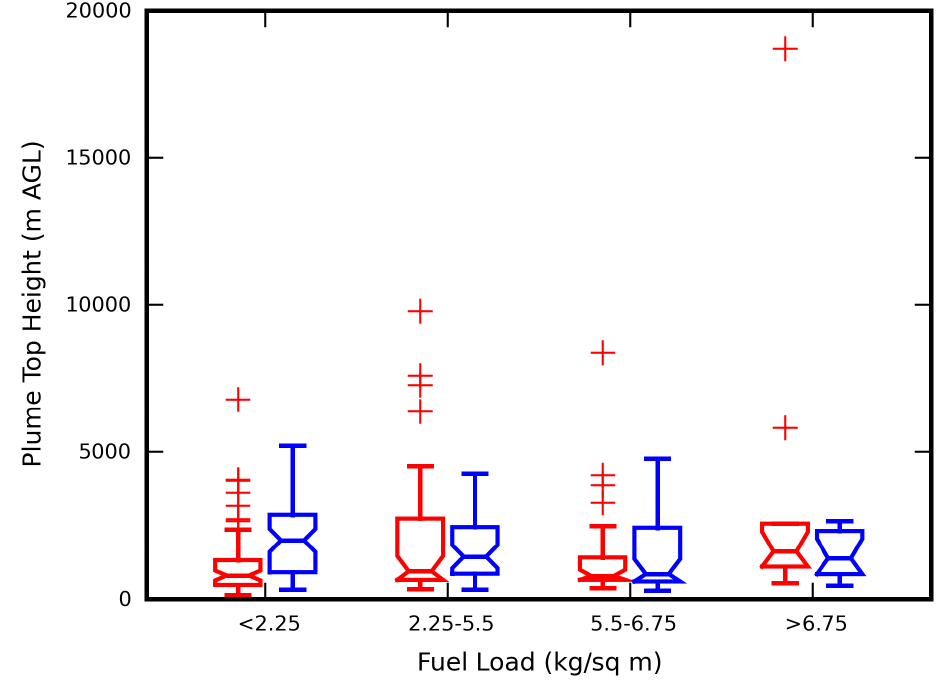
Figure 8. Notched box-whisker plot of the modeled (red) and MISR observed (blue) plume heights as a function of modeled fuel